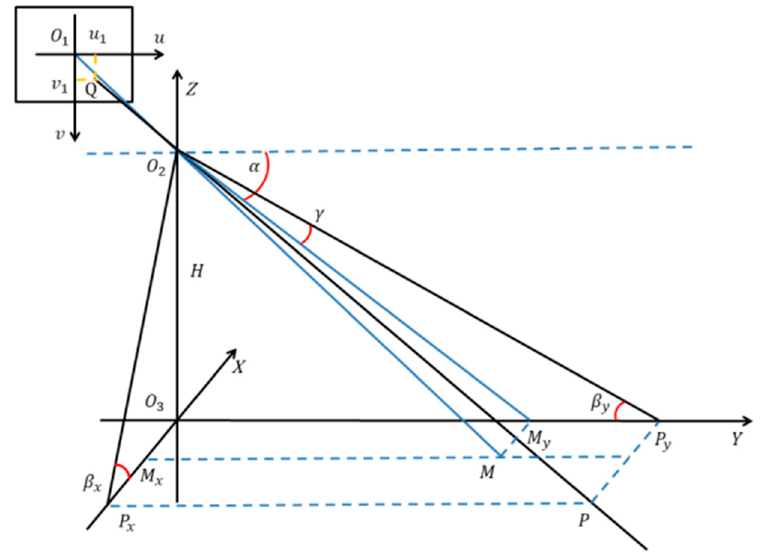
Figure 9. Projection transformation for estimating a target position.